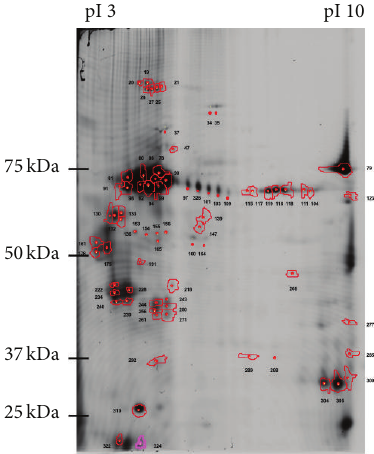
Figure 1: Representative raw 2DE gel of CyDye labelled proteins of ex vivo expanded human periodontal ligament stem cells and the location of proteins identified on the raw 2DE image. Following cell surface labelling with CyDye and membrane protein enrichment, proteins were separated by 2DE using a pI range of pH 3–10 and a molecular weight range of 10–110kDa. Following image analysis, 80 well-resolved protein spots were detected. A total of 32 membrane- associated protein spots were consistently found on replicate